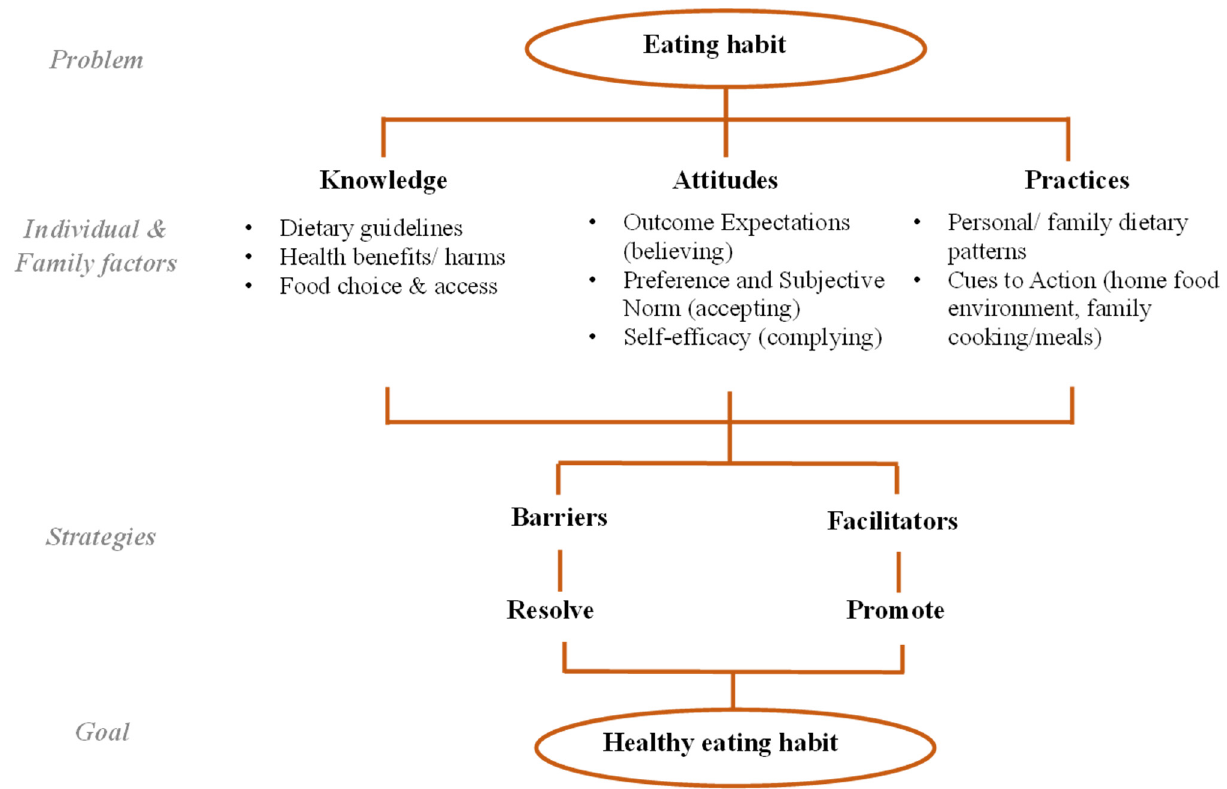
Figure 1. Theoretical framework for family interview: knowledge, attitudes, and practices